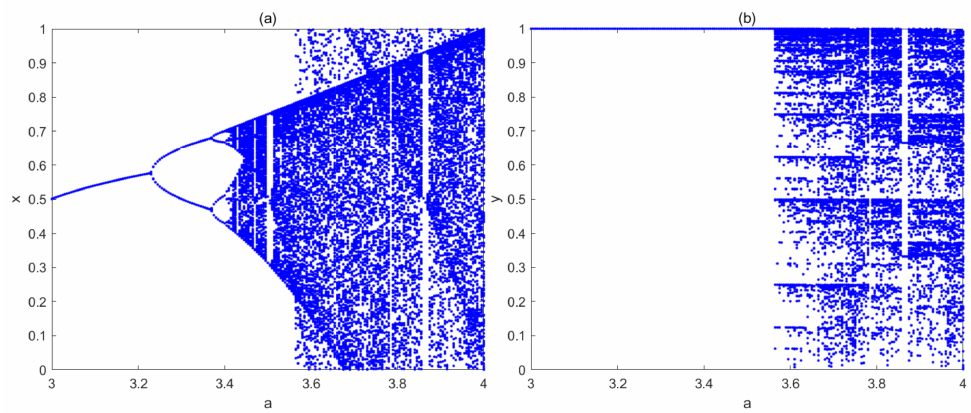
Figure 4. Bifurcation diagram of the LB compound chaotic map: ( a ) x-dimensional variable; ( b ) y-dimensional variable.